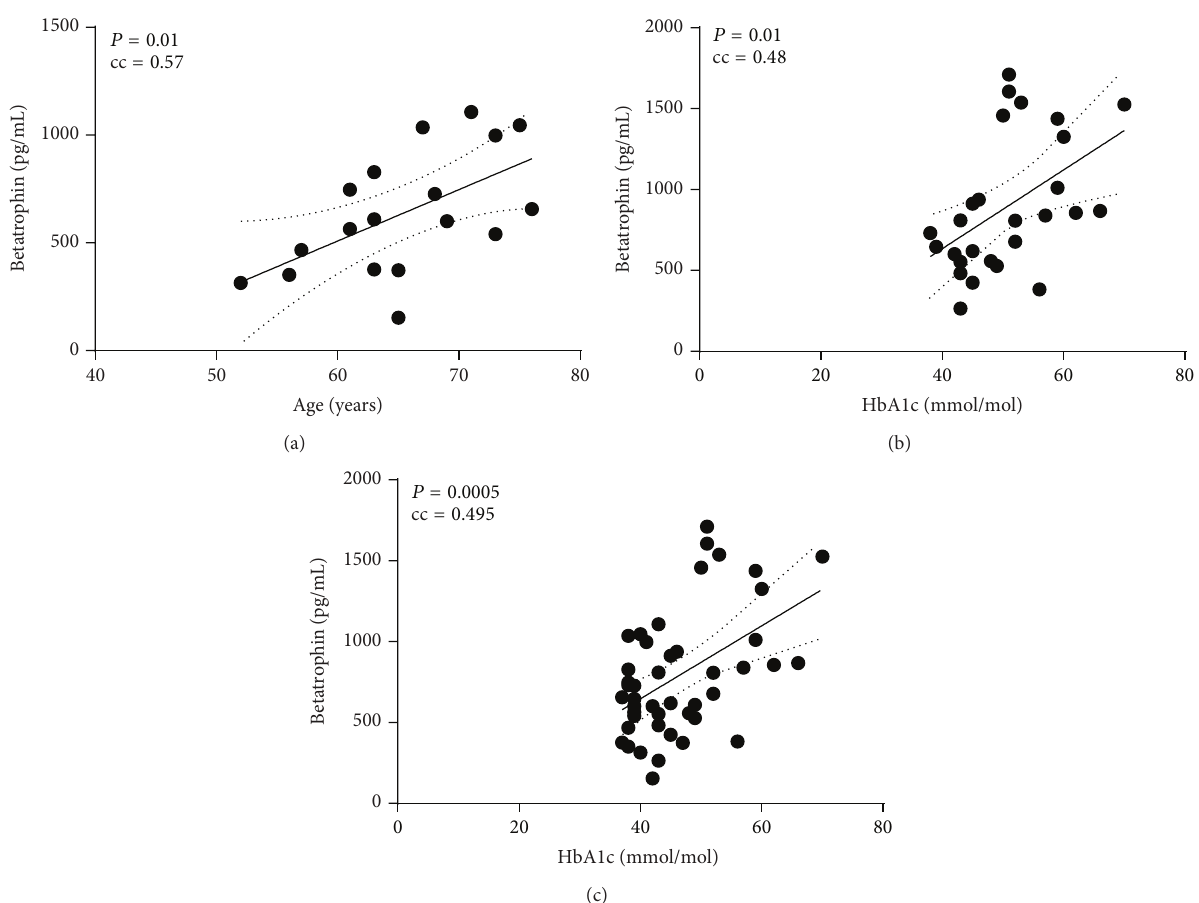
Figure 1: Correlation between betatrophin and age in nondiabetic controls (a) and HbA1c in patients with type 2 diabetes (b) and in all study participants (c). (a) Positive correlation between betatrophin and age in nondiabetic controls ( 𝑛 = 18 , cc = 0.57, and 𝑃 = 0.01 ). (b) Positive correlation between betatrophin and HbA1c for patients with type 2 diabetes ( 𝑛 = 27 , cc = 0.48, and 𝑃 = 0.01 ). (c) Positive correlation between betatrophin and HbA1c in all study participants ( 𝑛 = 45 , cc = 0.495, and 𝑃 = 0.0005 ). cc: correlation coefficient, also known as 𝑟 . Line; best fit with 95% confidence